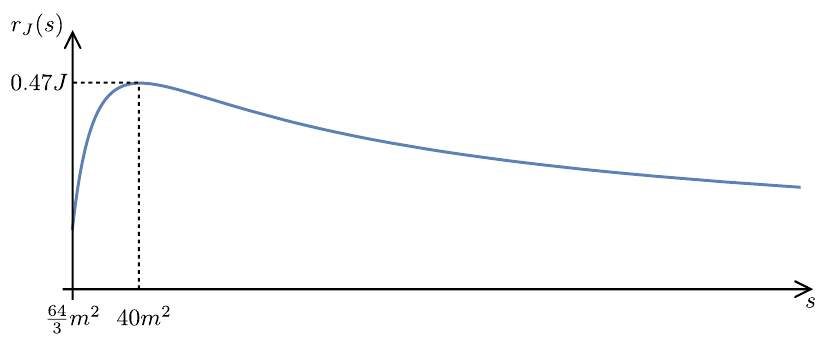
m 2 . The maximum 3